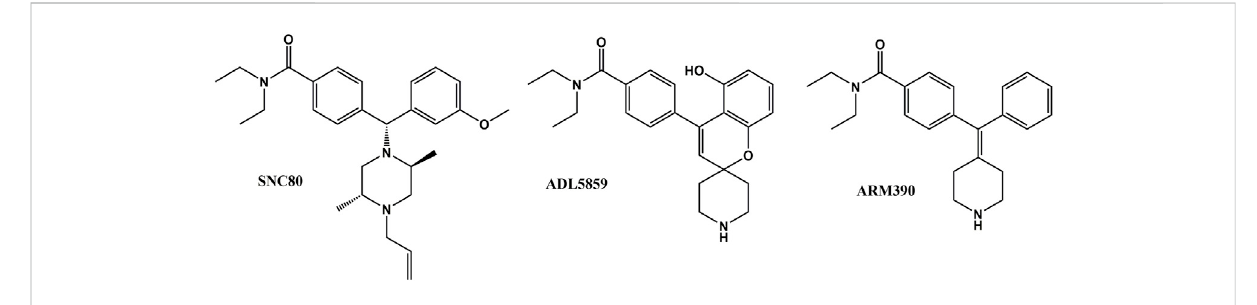
FIGURE 1 Chemical structure of SNC80, ADL 58589 and ARM